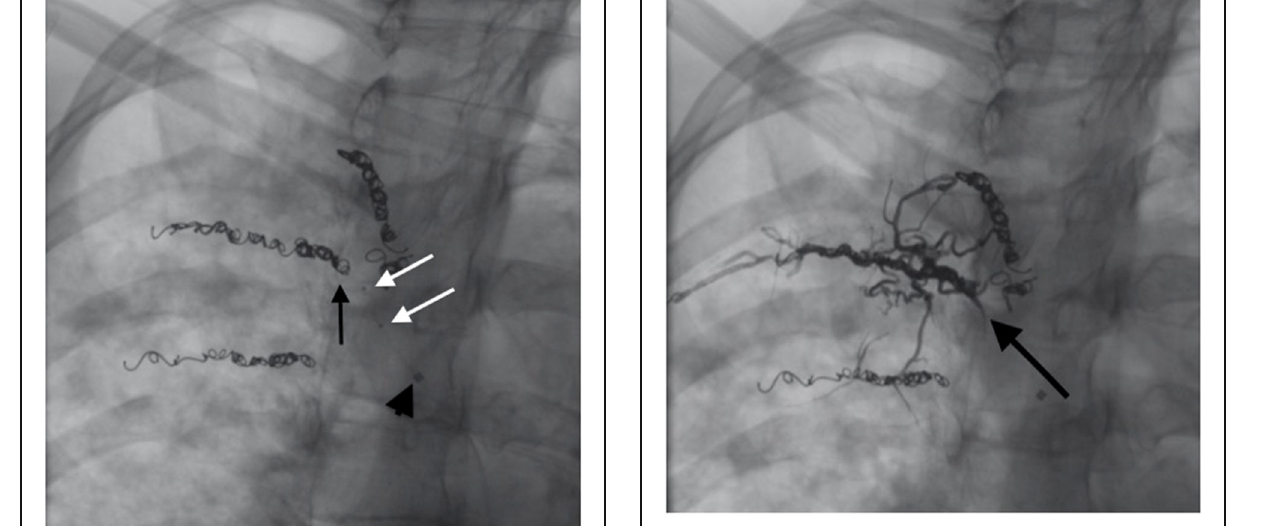
Fig. 4 Magnified slight RAO fluoroscopic image demonstrating